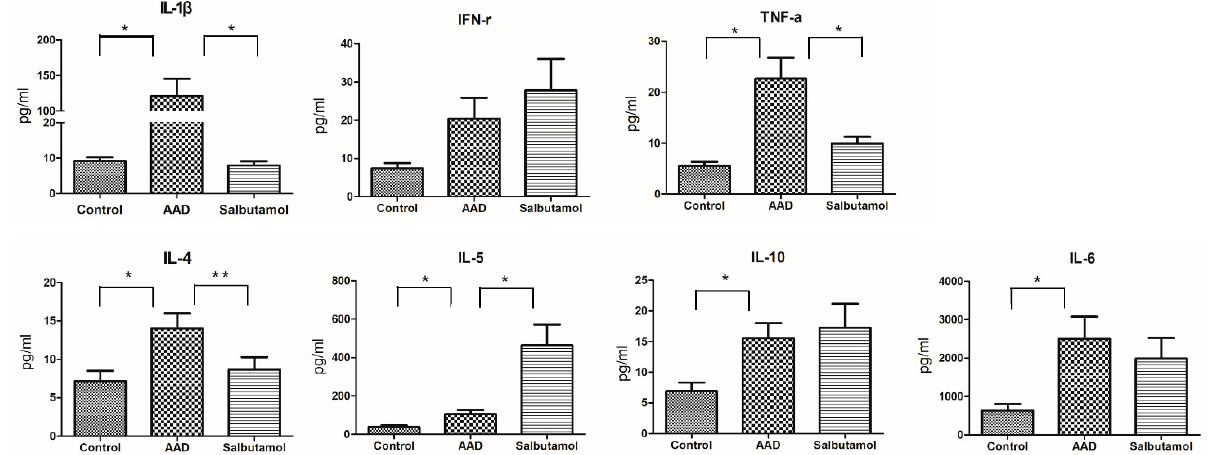
Figure 3. The results of cytokine ELISA assay. T-helper 1 (Th1) (IL-1 β , interferon [IFN]- γ , and tumor necrosis factor [TNF]- α ), Th2 (IL-4, IL-5 and IL-10), and proinflammatory cytokine (IL-6) levels were measured using ELISA with a multiplex protein assay kit. * p < 0.05, ** p = 0.064.